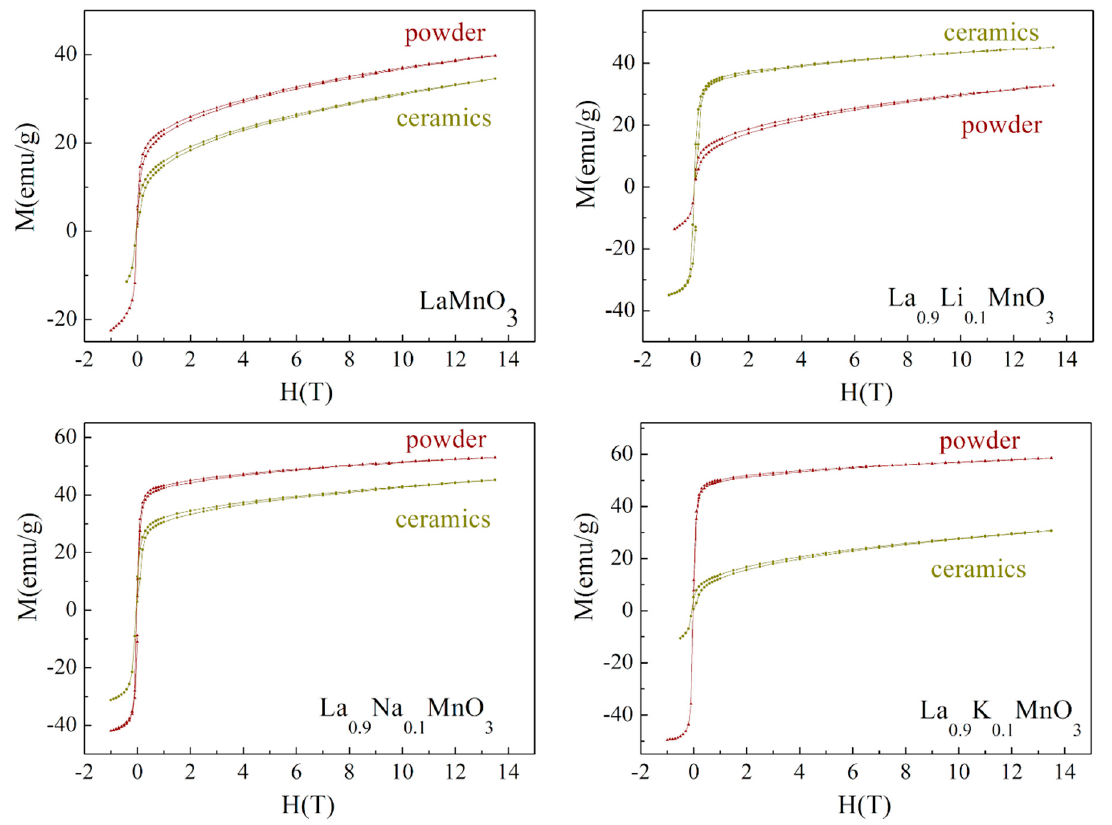
Figure 6. Isothermal magnetization curves measured for the initial compound LaMnO 3 and doped La 0.9 A 0.1 MnO 3 (A: Li— right top , Na— left bottom , K— right bottom ) powder and ceramics at T = 5 K.